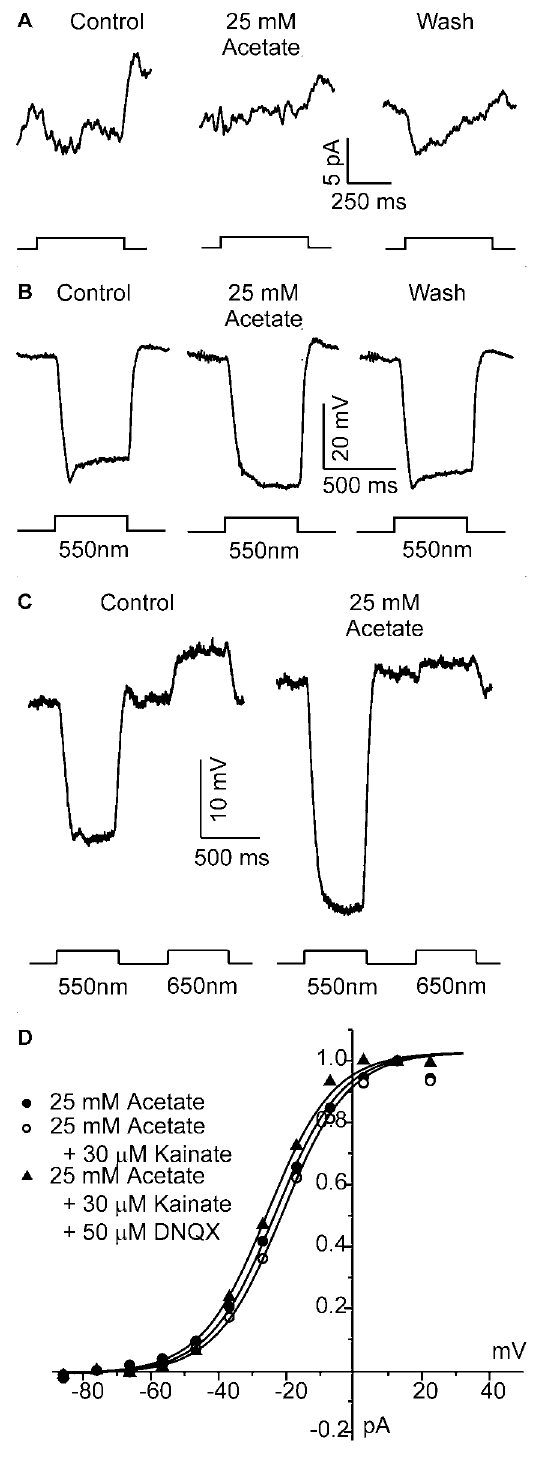
Figure 6. Intracellular acidification reduces feedback-mediated responses without hyperpolarizing horizontal cells in the isolated retina of goldfish. A , Feedback-responses elicited by a 500 ms full-field stimulus (I=0 log) delivered in the presence of a 20 m m spot of light (I=0 log) centered on a cone clamped at 2 38 mV. Current responses are shown in control (left), after application of 25 mM acetate (middle), and after washout (right). Acetate reduces feedback-induced inward currents in cones. B , Responses of a monophasic horizontal cell to 550 nm light (I=0 log), in control, after application of 25 mM acetate